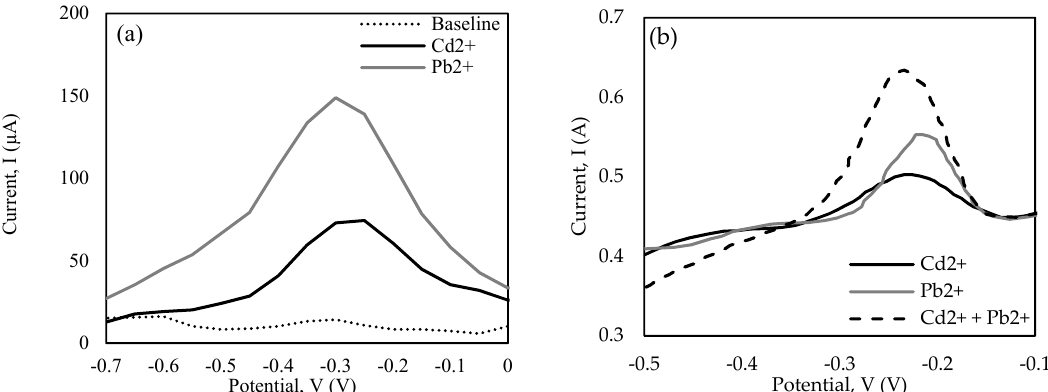
Figure 6. ( a ) Stripping peak of Cd 2+ and Pb 2+ using HMstat incorporated with a screen-printed gold electrode (SPGE). Experimental condition: deposition potential − 0.6 V; deposition time 120 s; modulation and step amplitude 50 mV and frequency 10 Hz. In 0.1 M acetate buffer. ( b ) Stripping peak of Cd 2+ (at − 0.195 V) and Pb 2+ (at − 0.18 V) under gold-based electrode, extracted from previous research [34].